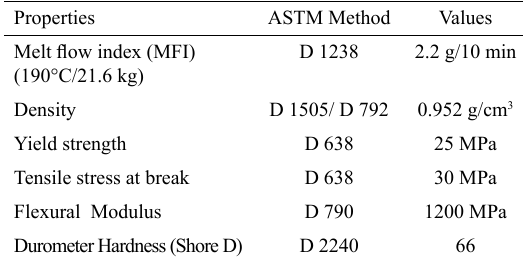
Table 1. Specifications of HMWPE (Braskem-HS5103) 1